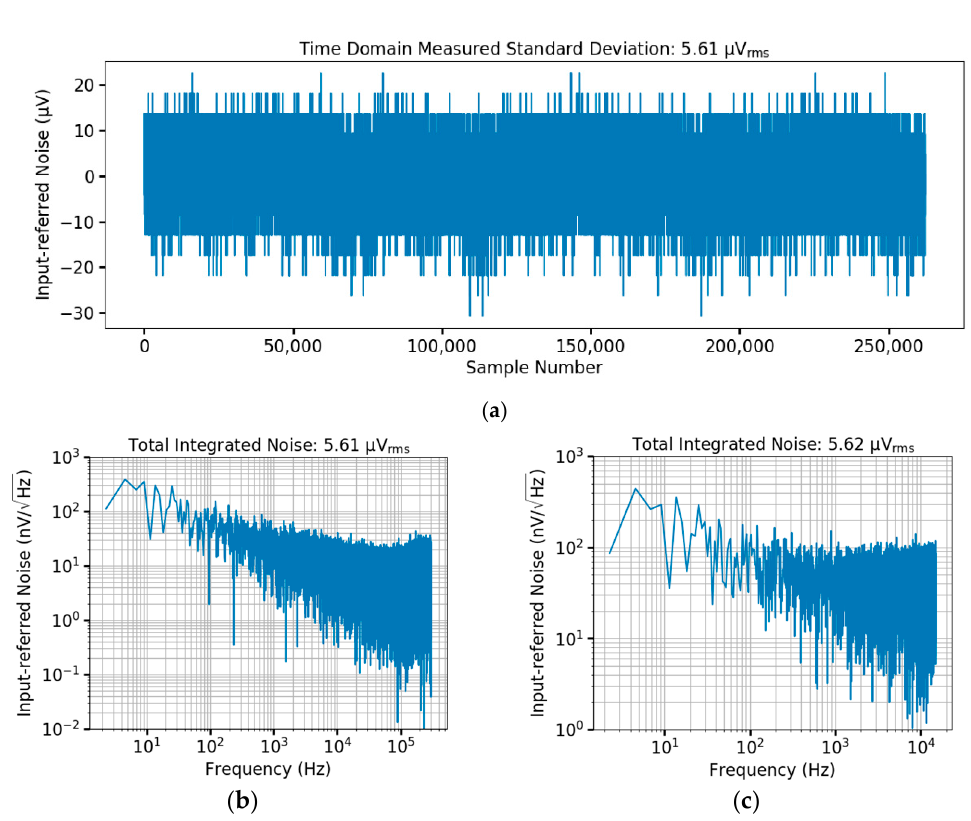
Figure 11. Full system input-referred noise measured from the ADC output codes. ( a ) Time domain plot of 262,144 ADC samples (400 ms time record); ( b ) Single channel FFT spectrum with sampling frequency of 600 kHz; ( c ) Spectrum of demultiplexed samples with 30 kHz sampling per channel.